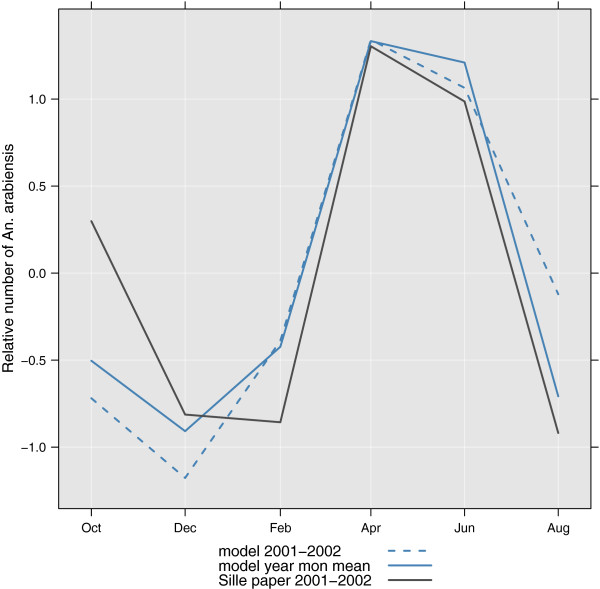
Scaled variations over time of An. arabiensis  in Sille, Ethiopia (data from TAY2006), observed (grey solid line), model 2001-2002 (solid blue line), model multi-year monthly mean (dashed blue line).